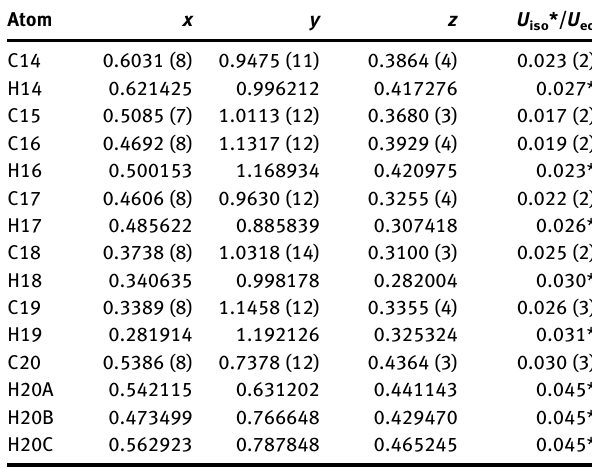
Table  : Fractional atomic coordinates and isotropic or equivalent isotropic displacement parameters (Å 